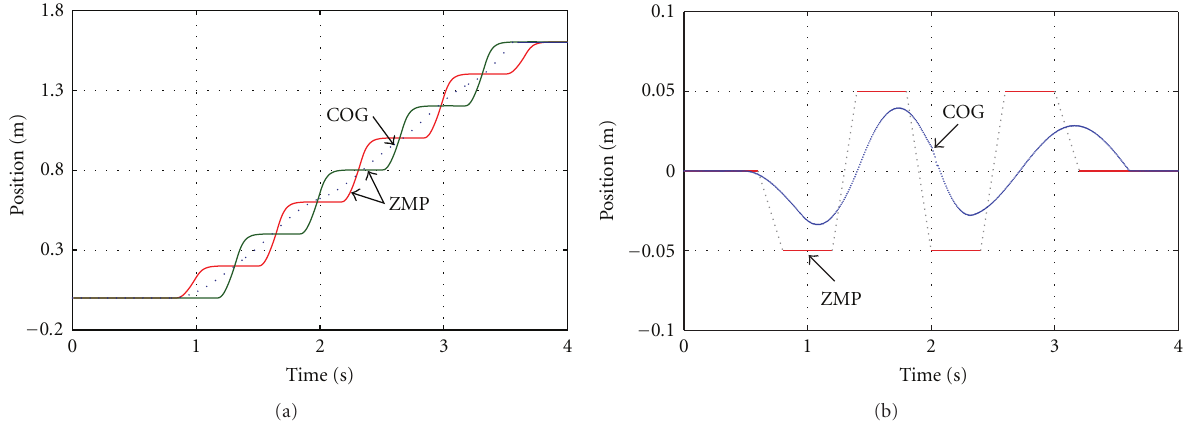
Figure 7: ZMP and CoG trajectories in X and Y axial